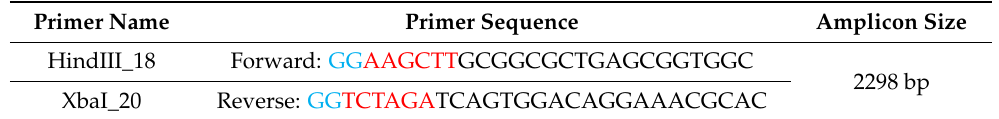
Table 3. List of primers used for PCR amplification of DNA insert for BRAF. Primers sequence consist of hybridization sequence that binds to the CDS sequence (marked in black), restriction site sequence (marked in red), that was specific for selected restriction enzymes, and leader sequence, which was extended by additional bases on the 5 (cid:48) end of the primer to improve cutting efficiency (marked in